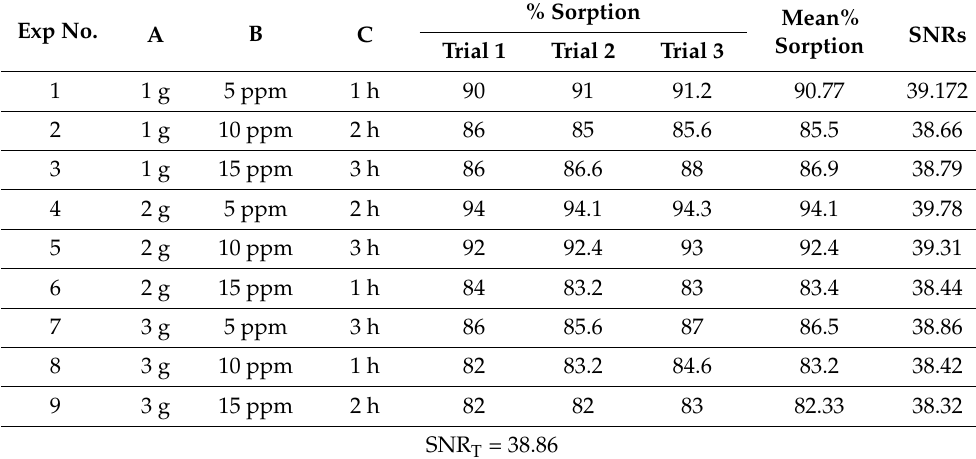
Table 1. Mean percentage sorption and SNRs for the experiments designed by L9 orthogonal array for Pb on defatted seed residue of C. melo.